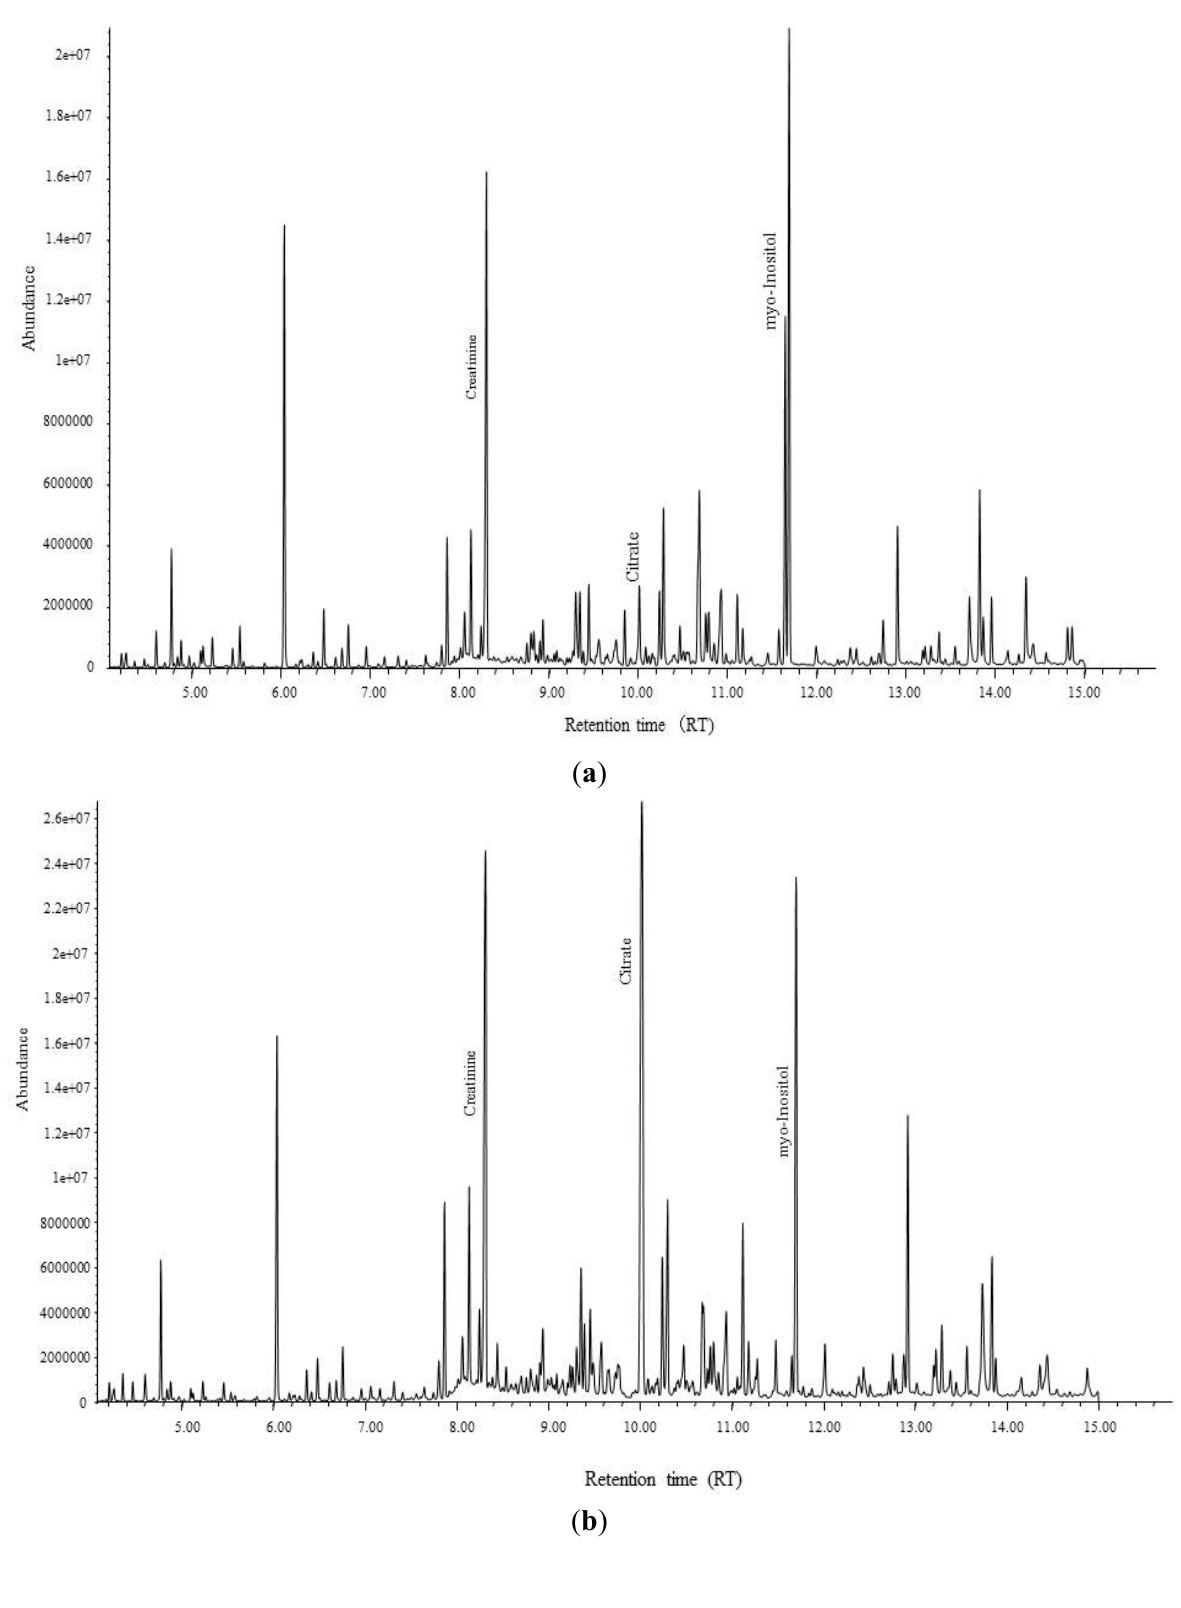
Figure 3. GC-chromatogram of ( a ) a highly Cd exposed case in Mae Sot, and ( b ) a control case in non-polluted